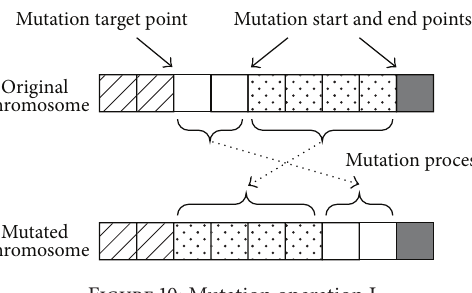
Figure 10: Mutation operation I.